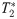
2D correlation histograms showing the effects of registration.Columns refer to T1 (a, c), T2* (b, d) and χ (e, f) maps, while rows show either mis-registration (a, b, c) or self-registration (d, e, f) effects, respectively. The mis-registration and the self-registration effects are here illustrated by comparing each map with itself: after the application of a small transformation without registration (mis-registration) or after the application of a large transformation followed by a registration step (self-registration). The x-axis indicate the unmodified map, while the y-axis indicate the transformed or self-registered map. The small tranformation considered for the misregitration is a 0.5px translation followed by a 0.5° rotation. The large transformation considered for the self-registration is a 10° rotation.